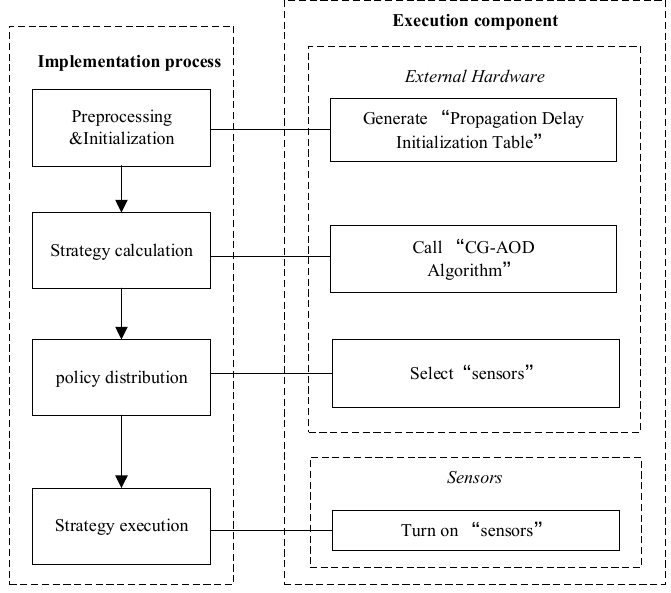
Figure 2. Implementation Process Framework